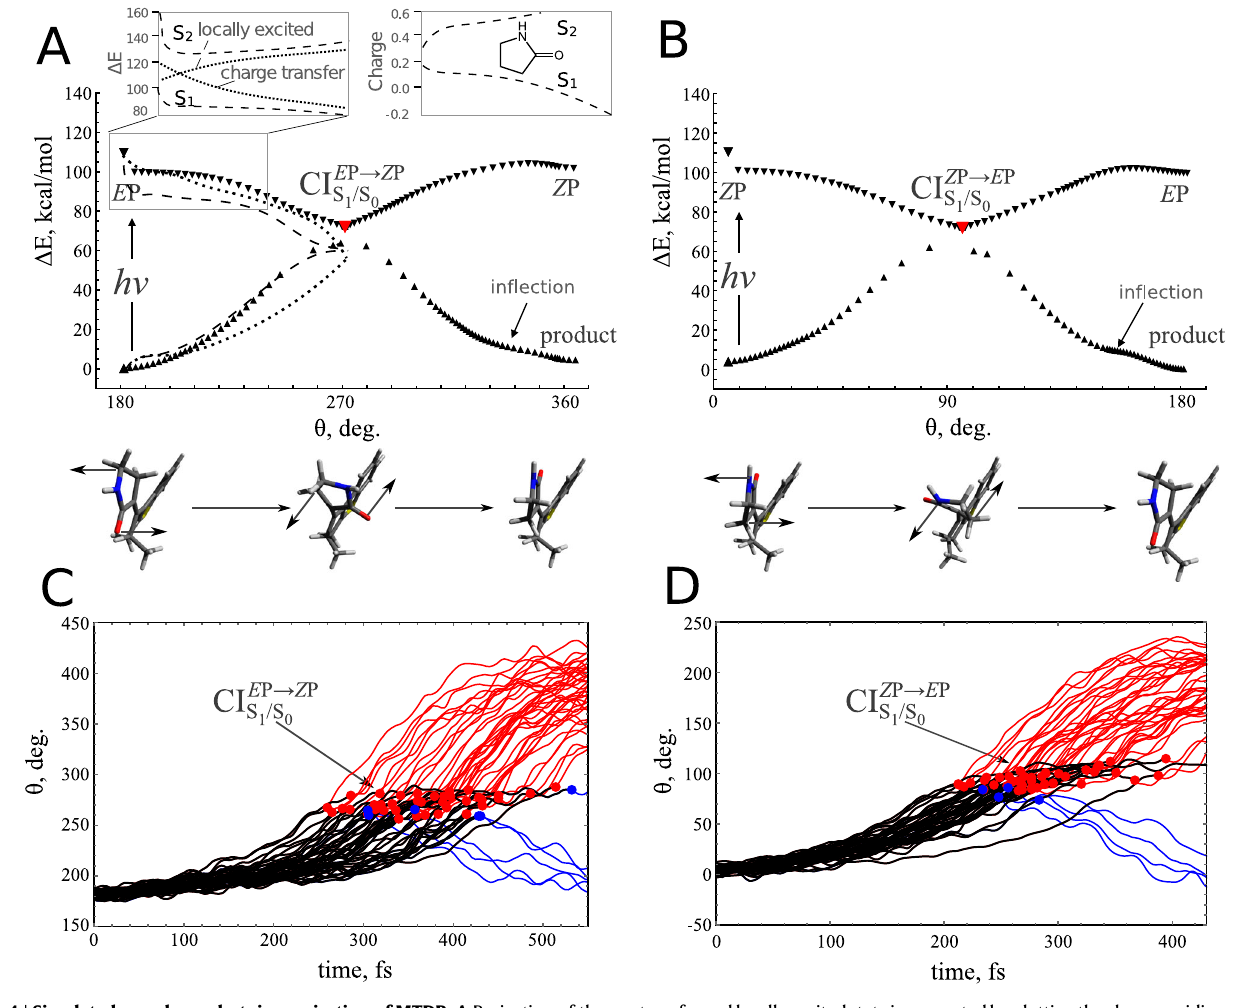
transferandlocallyexcitedstateissupportedbyplottingthechargeresidingonthe pyrrolidinone(alsocalledoxindole)ringinthetwostates.The S 1 → S 0 nonadiabatic , which is shown by the red fi lled relaxation occurs near the geometry of CI S 1 = S 0 triangle. B The same for the Z P → E P step. C θ propagation during the quantum- classical population dynamics starting from E P. The propagation along the S 1 PES (the black lines) is connectedwith the productive (the red lines) and unproductive (thebluelines)propagationalongthe S 0 PESbythecorrespondinghoppoints(the seam. D The same for the red and blue circles) “ imaging ” a segment of the CI S 1 = S 0 Z P → E P step. Source data are provided as a Source Data fi